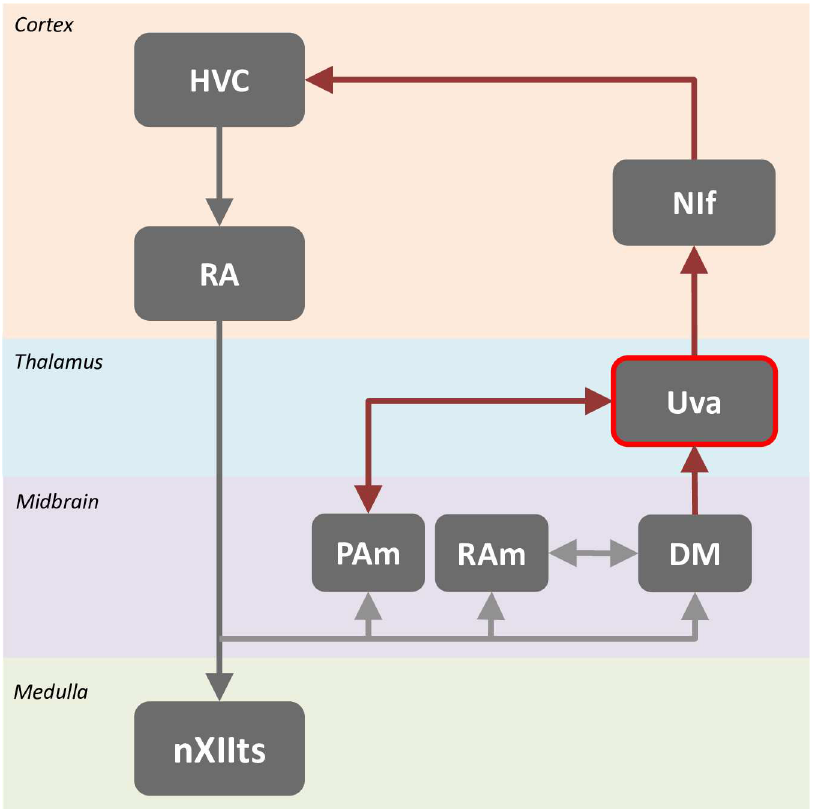
Fig 1. The avian premotor song circuit can be viewed as a combination of a feed-forward premotor pathway (gray arrows) combined with a feedback pathway (brown arrows). HVC (used as proper name); RA (robust nucleusof the arcopallium);nXIIts (tracheosyringealportion of the hypoglossal nucleus); PAm (nucleus parambigualis); RAm (nucleus retroambigualis);DM (dorsomedial medial nucleusof the intercollicular complex); Uva (nucleus Uvaeformis); NIf